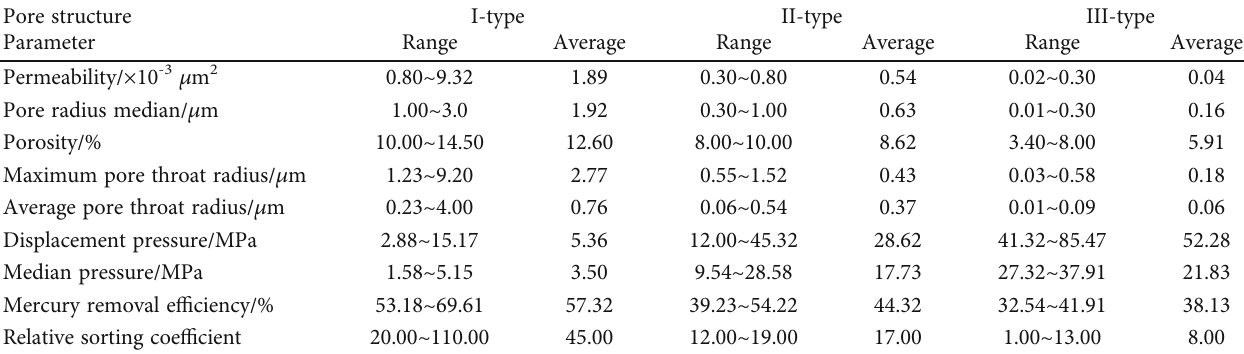
Table 4: Classi fi cation standards of micropore structure in tight oil reservoir. Pore